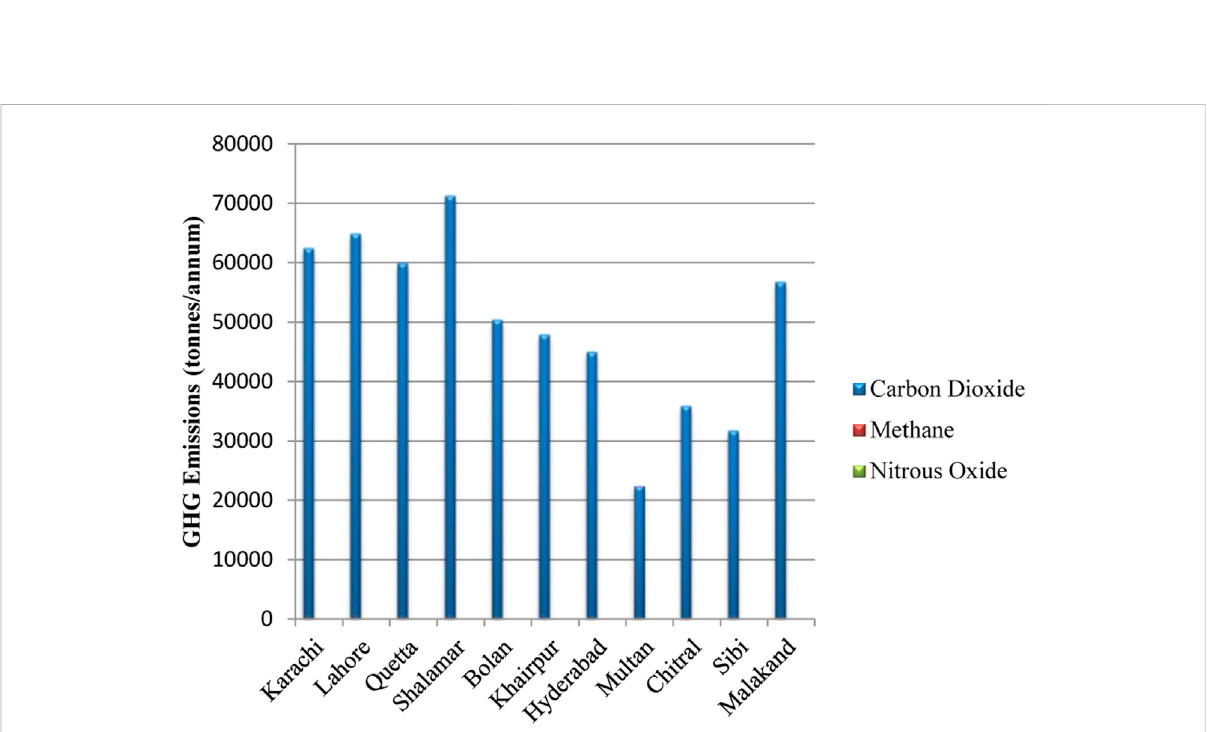
FIGURE 2 Breakdown of annual GHG emission load from all vessels of PNSC based on fuel consumption